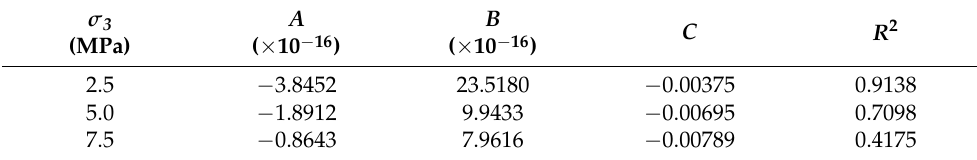
Table 5. Variables in Equation (14) for different confining